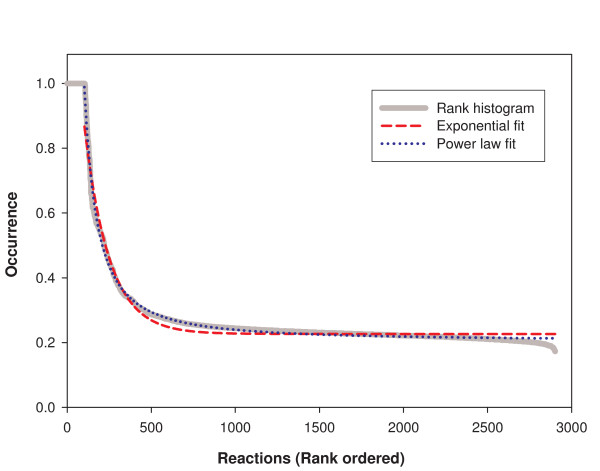
Rank histogram of reactions based on their occurrence. The horizontal axis shows the 2902 reactions in our global reaction set ordered based on their rank. The vertical axis shows the occurrence of each reaction in 1000 randomly sampled genotypes that are viable in a glucose environment, with n = 831 equal to that of E. coli. The occurrence of a reaction is given by the number of sampled genotypes containing the reaction, divided by the sample size of 1000. Reactions have been ordered based on their decreasing occurrence, with rank "1" corresponding to reaction with highest occurrence. All super-essential reactions have an occurrence of 1.0 and contribute to the horizontal plateau on the left of the rank histogram. We also see a larger plateau on the right, with an associated occurrence value of approximately 0.2. The two plateaus are connected by a degraded slope, corresponding to reactions that see their occurrence decrease continuously from 1.0 to 0.2. To study this region of the rank histogram, we have fitted it to two classes of functions: a constant plus an exponential (f(r) = a + b exp[-c r]; a = 0.2267, b = 1.293, c = 0.006827) and a constant plus a power function (f(r) = a + b/rc; a = 0.2052, b = 458.9, c = 1.375). Based on the coefficient of determination R2, the power law provides a better fit (R2 = 0.9645 for the exponential and R2 = 0.9927 for the power).